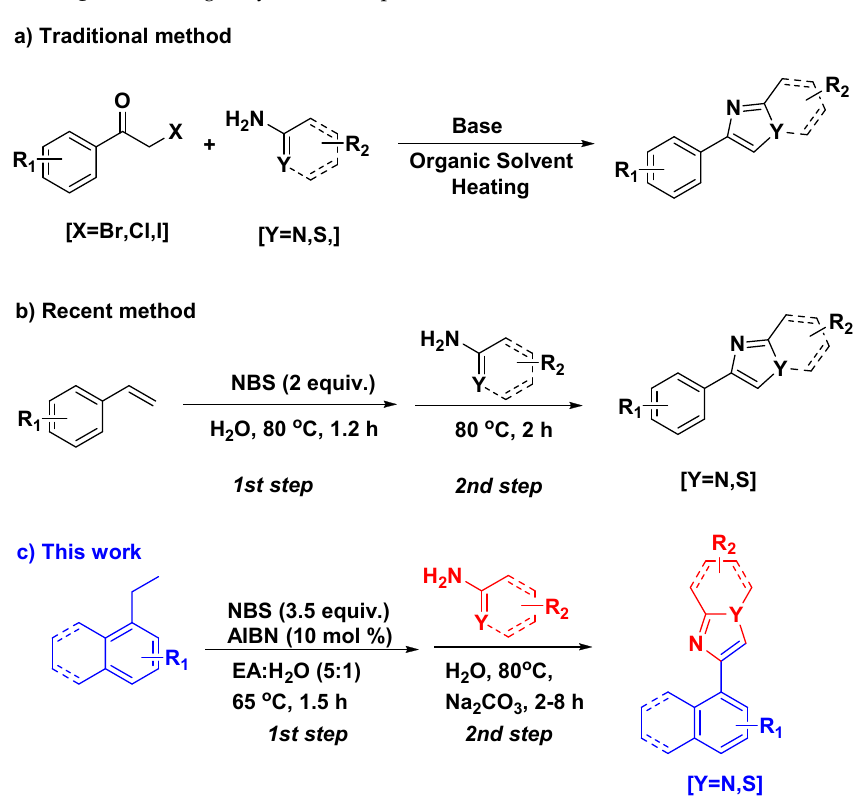
Scheme 1. Approach for the synthesis of imidazoles and thiazoles .